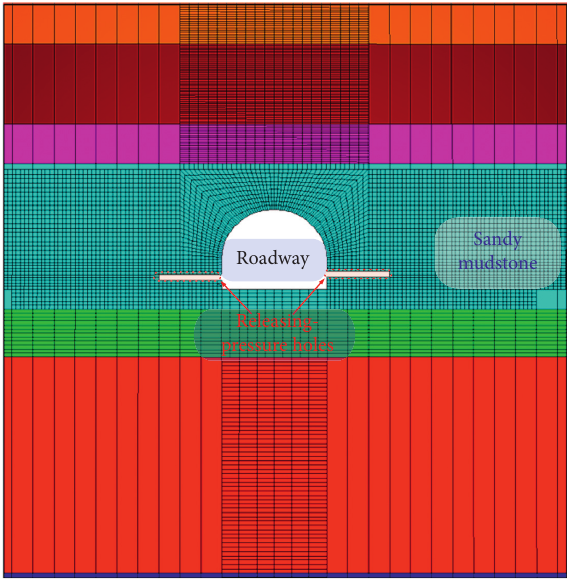
Figure 13: Numerical simulation model.